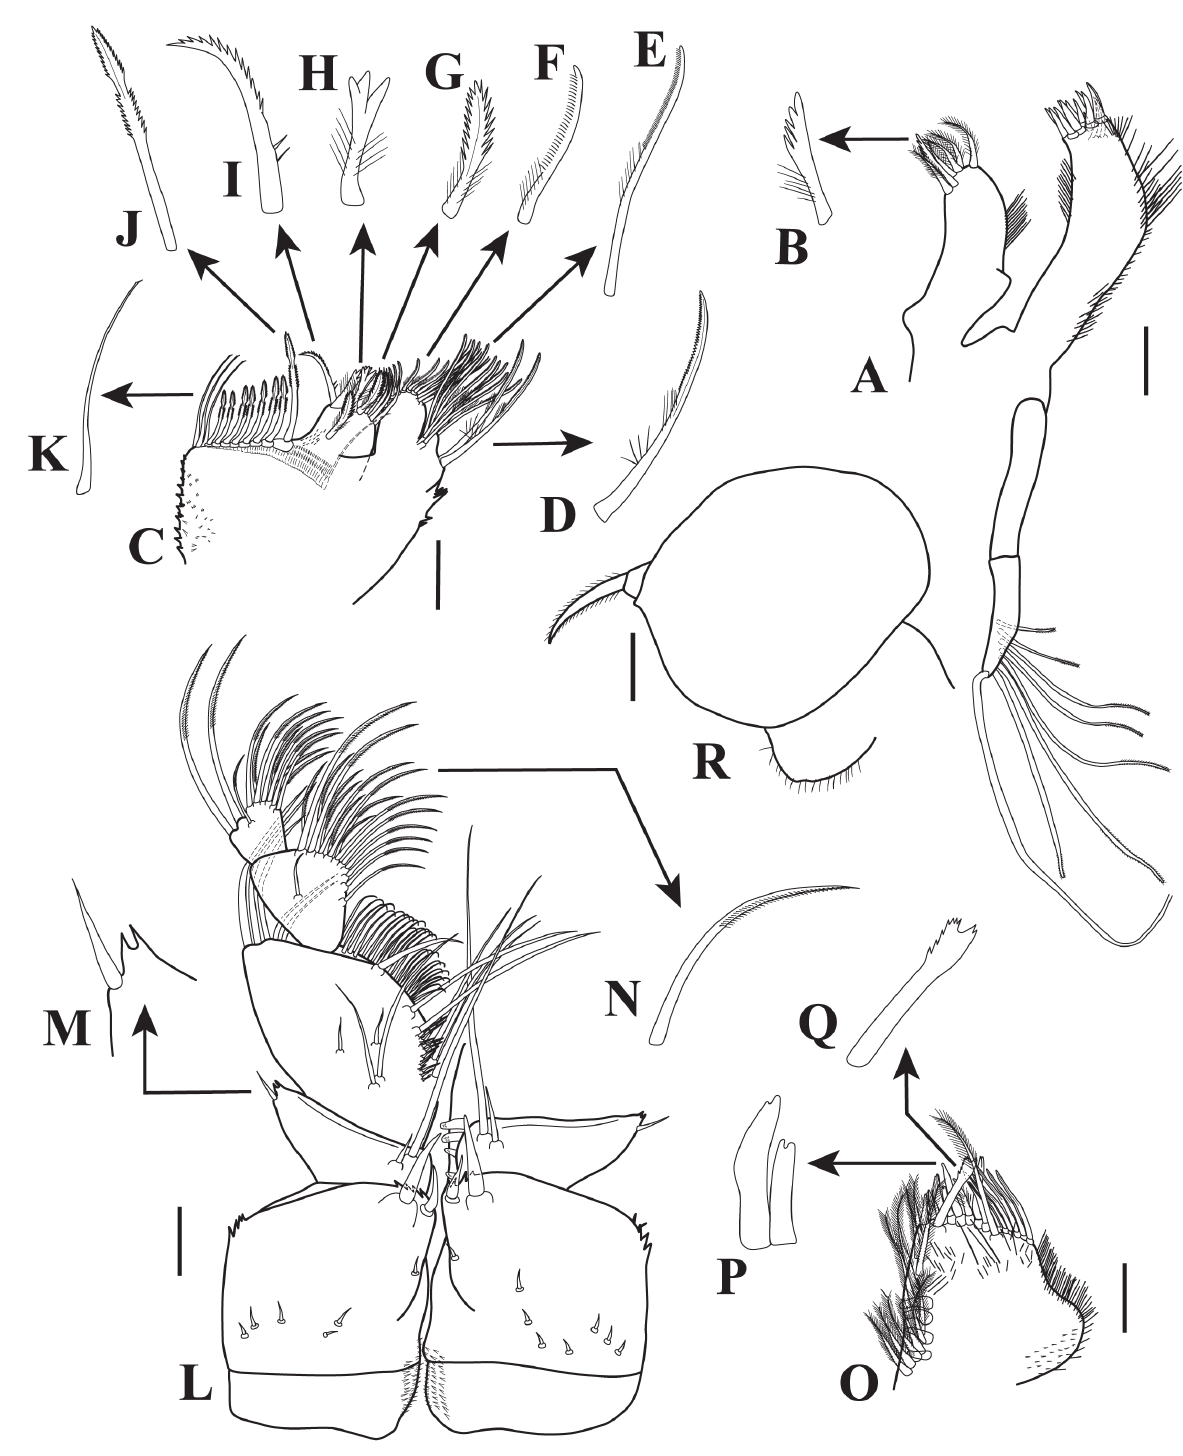
Figure 5. Brachylicoa lui sp. n. holotype female with oostegites and genital cone. A maxillule; B enlargement of penta-furcate spiniform setae; C maxilla; D − F , enlargement of inner pinnate-plumose spiniform setae; G enlargement of bipinnate-outer setulose spiniform seta; H enlargement of trifurcate-plumose spiniform seta; I enlargement of outer pectinate-outer setulose spiniform seta; J enlargement of bipinnate spiniform setae K enlargement of bifid basally-swollen seta; L maxilliped; M enlargement of distal outer margin of maxilliped palp-1; N enlargement of inner-setulate spiniform seta; O endite, P apically-bidentate spiniform setae; Q en- largement of leaf-shaped bifid spiniform seta; R epignath. Scale bars = 0.1 mm for A , C , L , O , R